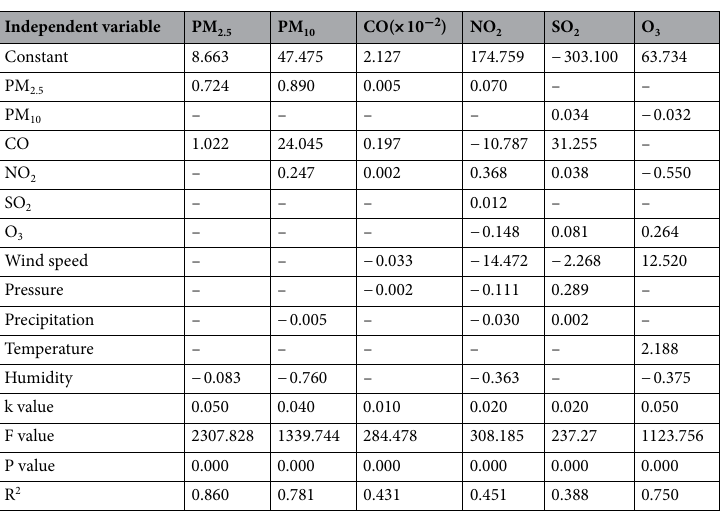
Table 3. LASSO regression model of six types of air pollutant concentrations. In the model, the dependent variable is the concentration of the six pollutants at the national control point, and the independent variable is the original data monitored by the self-built point (– represents the variables eliminated in the model).